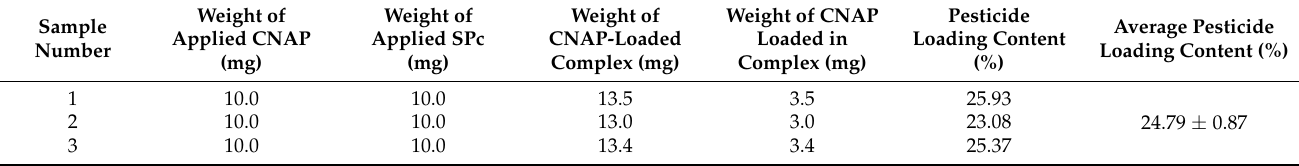
Table 1. Loading capacity of SPc toward CNAP using freeze-drying